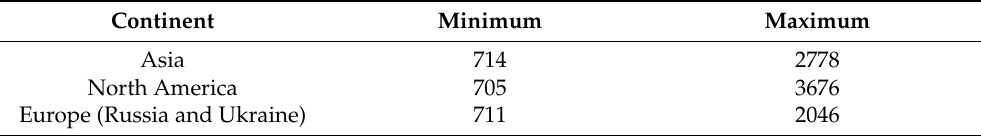
Table 1. Minimum and maximum mean AGDD 10 in 2003–2020 ( ◦ C) in the grid squares currently occupied by A. planipennis in different continents. Continent Minimum